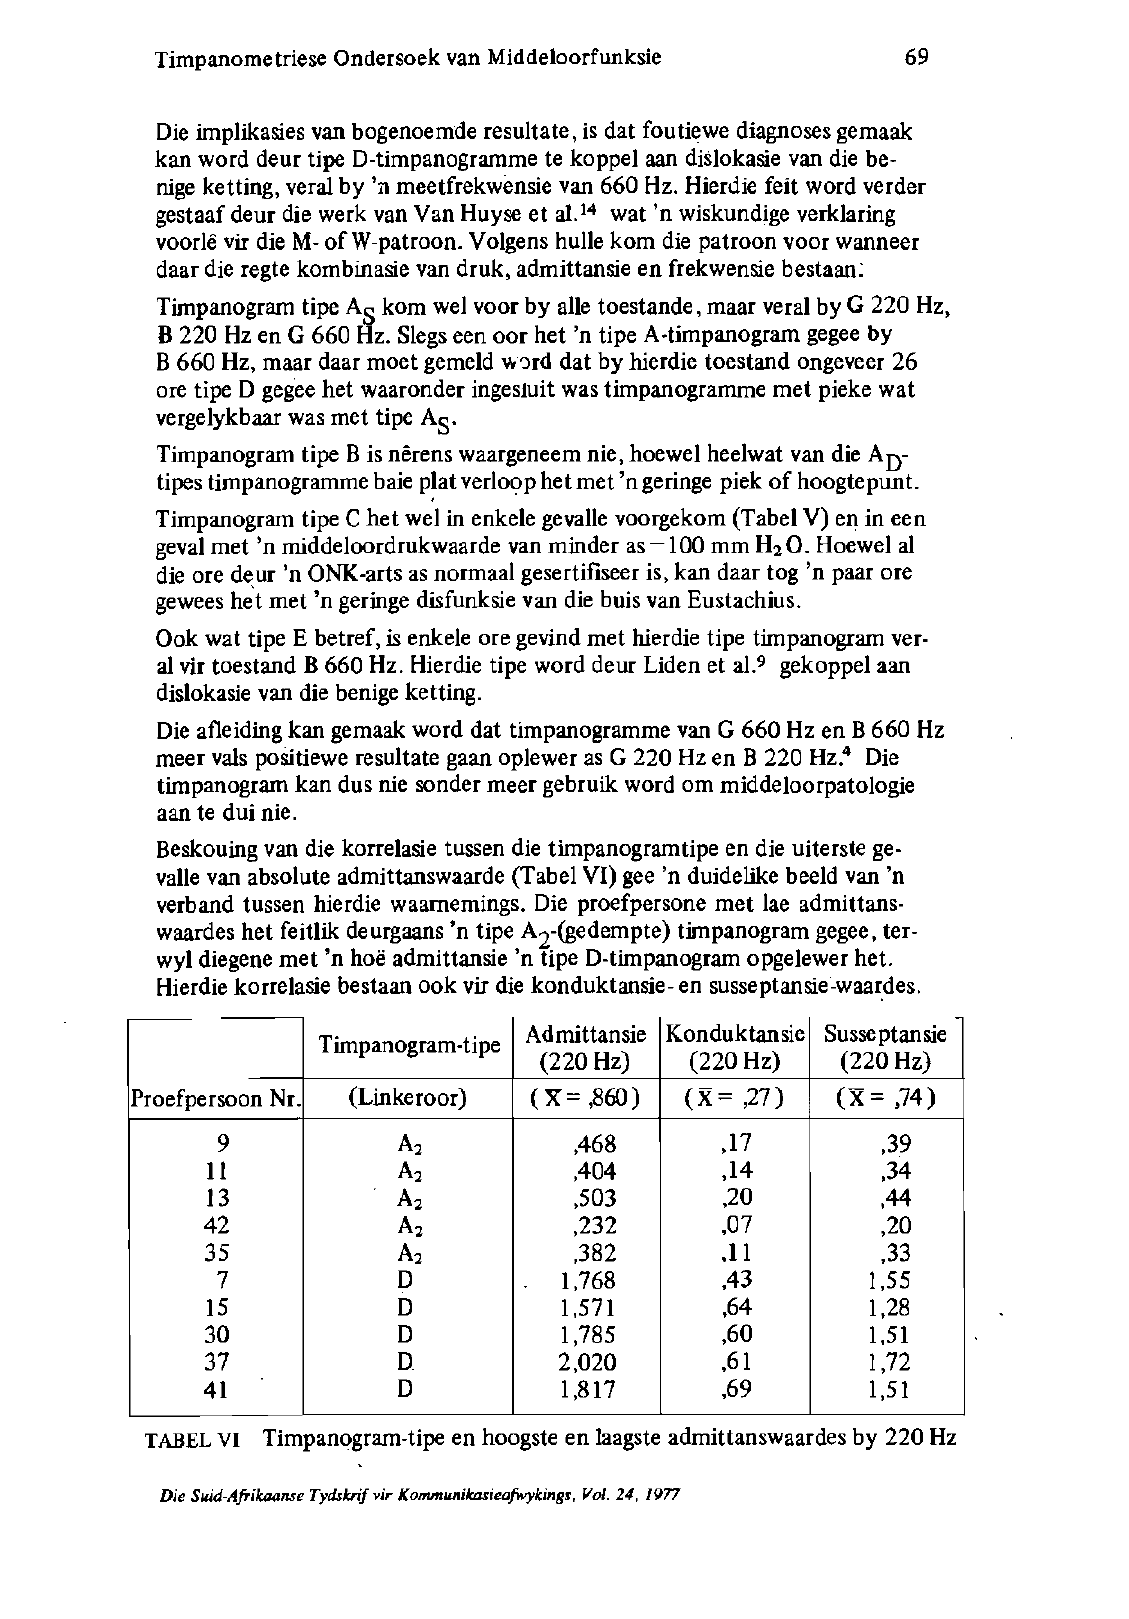
TABEL VI Timpanogram-tipe en hoogste en laagste admittanswaardes by 220